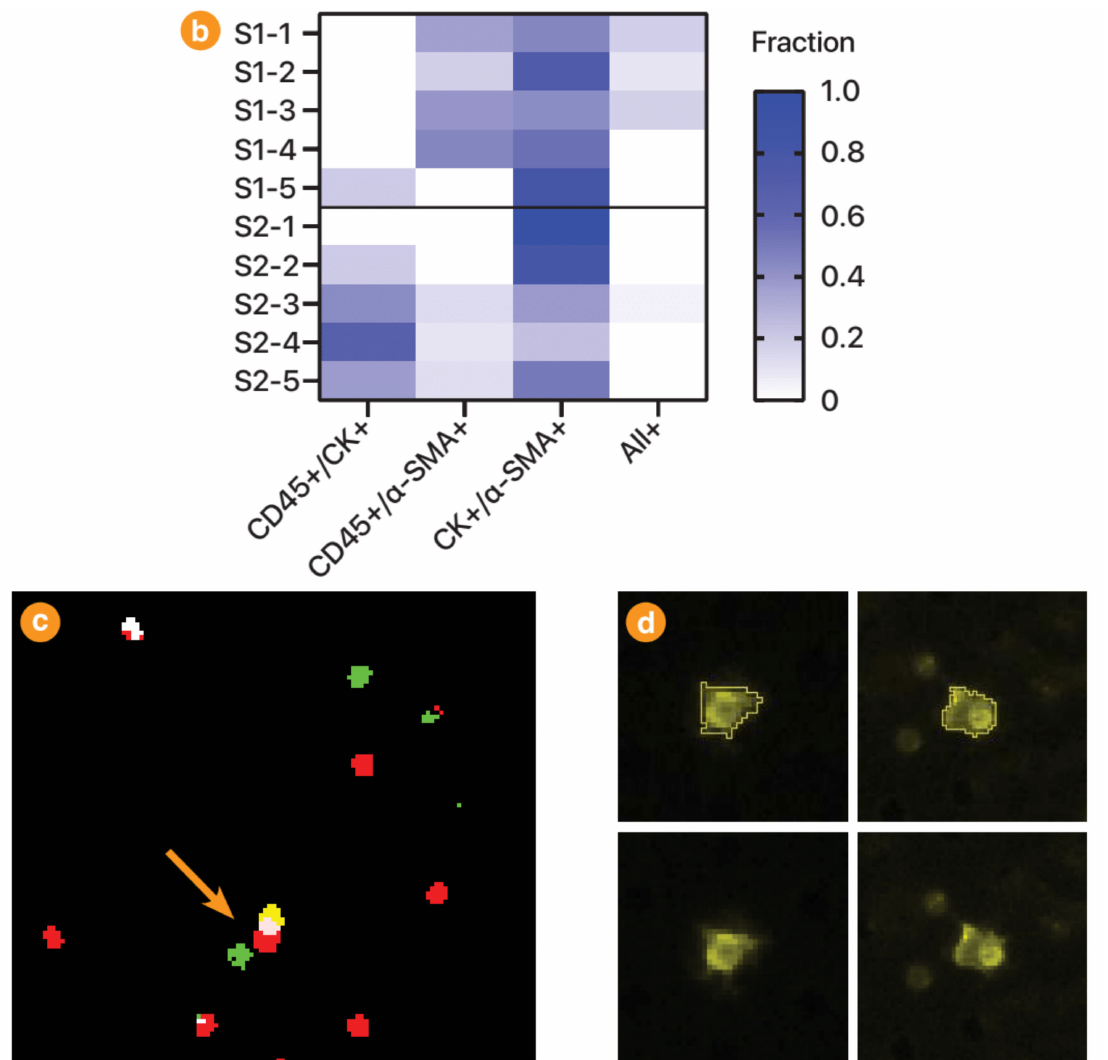
Figure A4. Summary of the semi-automated counting strategy. ( a ) Images were processed as four separate channels for background subtraction and initial thresholding. In this process, the experimenter was blinded to the treatment groups but not to the details regarding animal set and imaging date. These factors were taken into account to minimise the variation between samples of the same set and those which were imaged on the same day. After combining the images, a quality check (QC) was performed by screening for overlapping (indeterminate) staining. The thresholding for samples with >10% indeterminate cells were adjusted, aided by the pattern of indeterminate staining as visualised by a heatmap. ( b ) Example of the QC heatmap, which provides guidance for further threshold adjustments. Each row represents a low powered field (LPF). Each sample comprised five LPFs. Each column represents the staining characteristics as determined by the current threshold settings. The colour of the cells represent the fraction of the total number of indeterminate cells in the LPF with the given staining characteristic. In this heatmap, sample 1 (S1) demonstrates a high fraction of indeterminate cells with CD45+/ α -SMA+ and CK+/ α -SMA+, indicating that the α -SMA threshold is likely too low. In contrast, sample 2 (S2) has a high proportion of indeterminate cells with CD45+/CK+ and CK+/ α -SMA+. This indicates that the CK threshold required adjustment. ( c ) Example of a binary image map used to identify CTC clusters. The cell identity of each cell is represented by a colour (leucocyte: red, CTC: green, cPSC: yellow and indeterminate: white). In this image, most cells exist as individual cells (five leucocytes, two CTCs, one indeterminate), except for a cell cluster composed of a cPSC, leucocyte and a CTC (indicated by the arrow). The cluster represented in this binary image map corresponds to the third heterotypic cluster shown in Figure 1d. ( d ) Examples of using the magic wand function to mark out a region of interest (ROI) corresponding to cPSCs. Once a ROI was determined, the measurement tool in ImageJ was used to measure characteristics such as maximum Feret diameter and staining